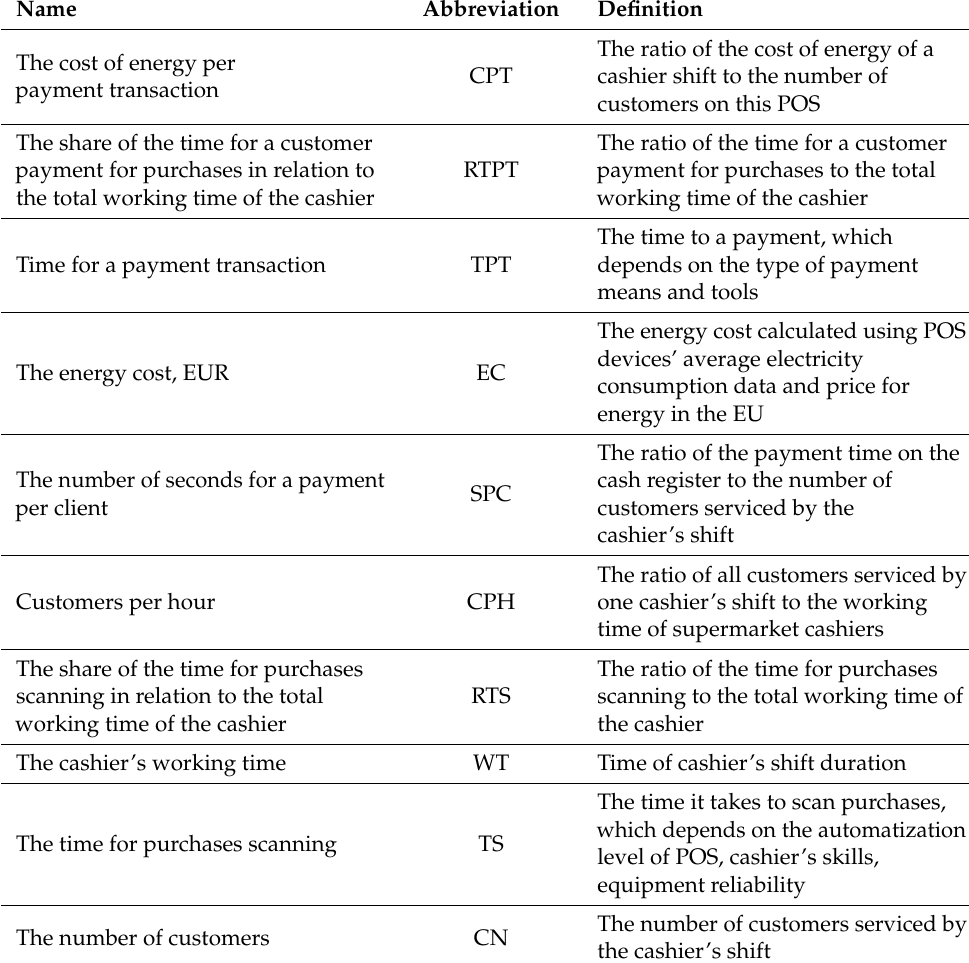
Table 1. Variables employed in the panel data